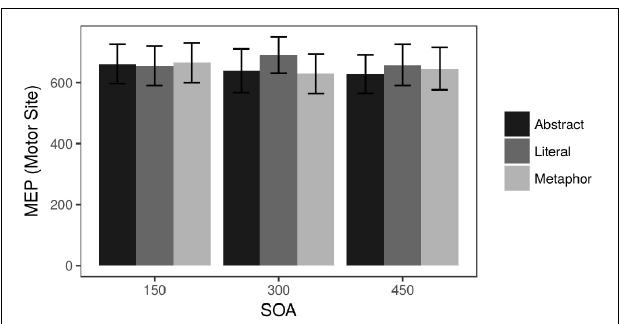
FIGURE 3 | Raw MEP data (microvolts) during Motor site